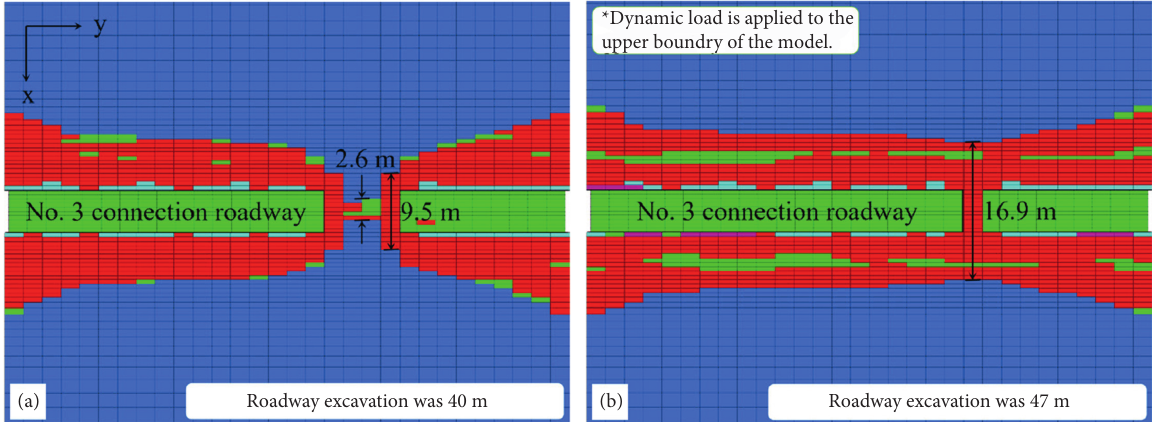
Figure 11: Distribution of surrounding rock plastic zone along the direction of excavation. Roadway excavation was (a) 40m and (b)